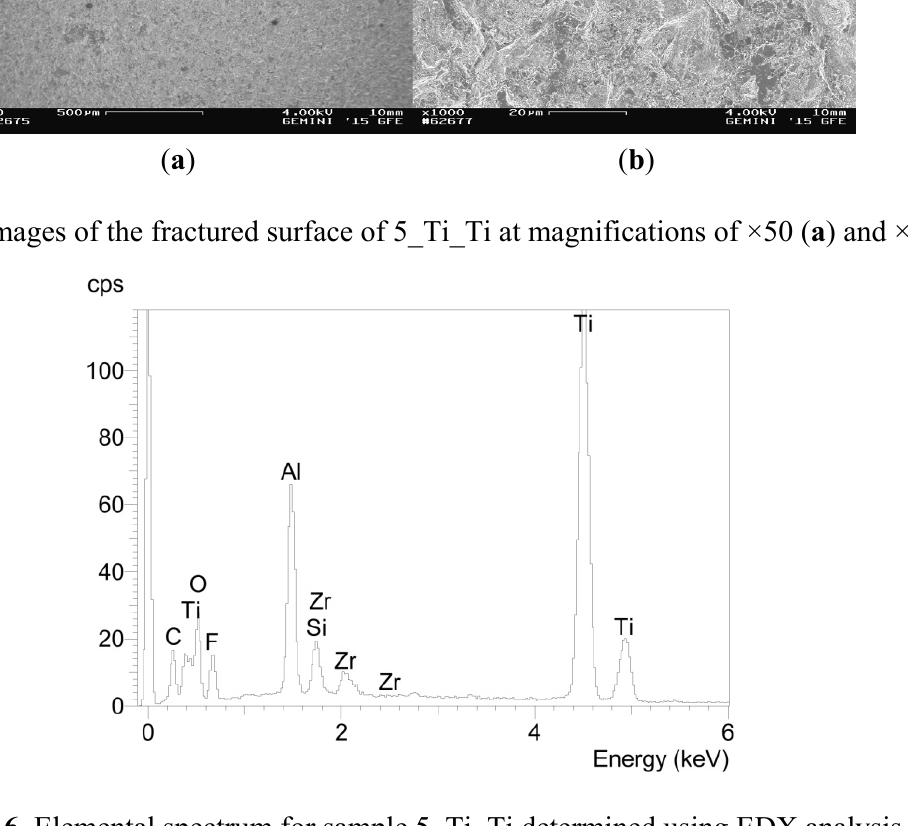
Figure 6. Elemental spectrum for sample 5_Ti_Ti determined using EDX